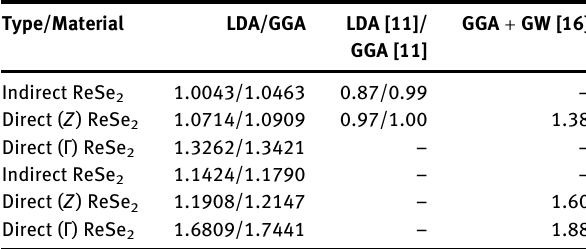
Table  : Bandgap values calculated within LDA and GGA. Type/Material